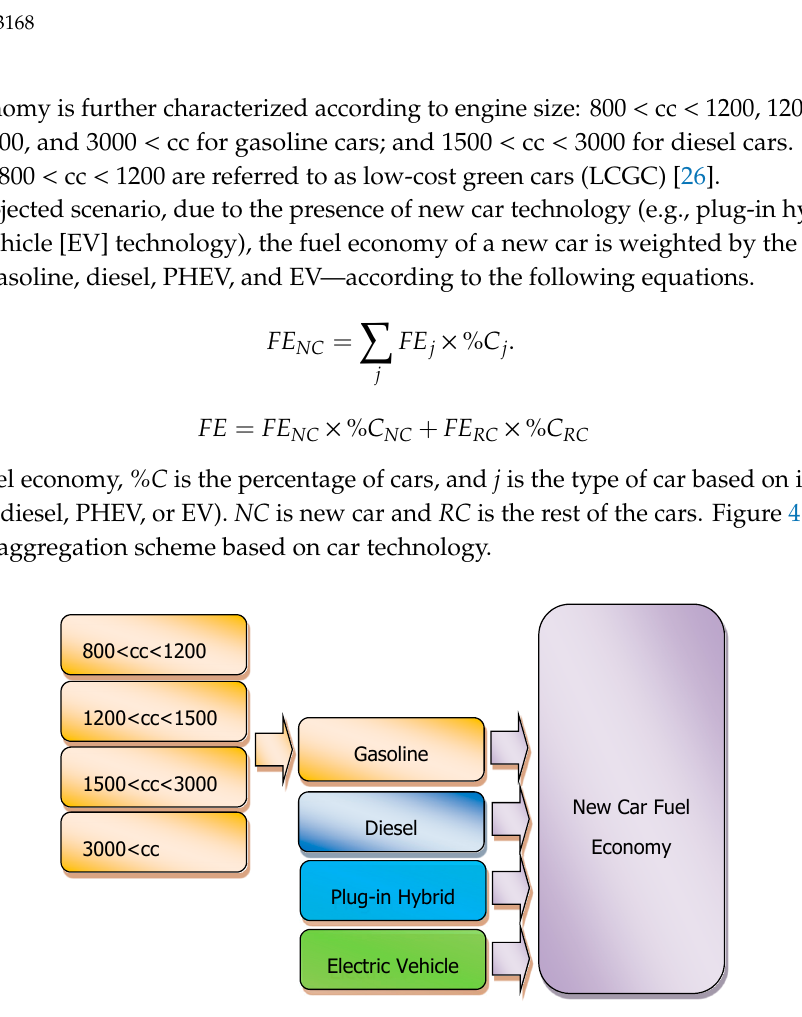
Figure 4. Fuel economy aggregation scheme based on car technology.